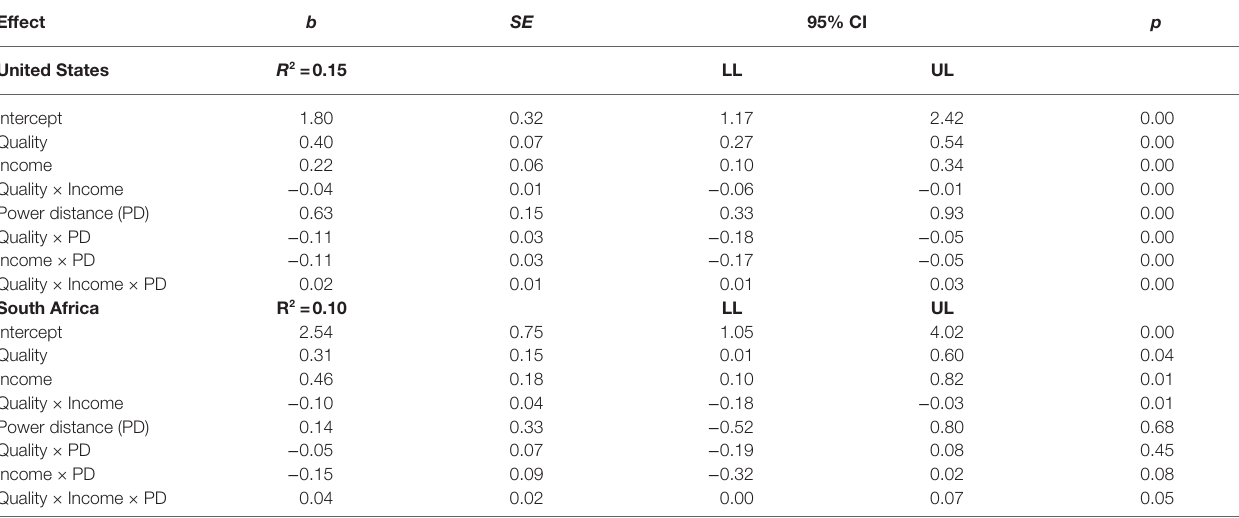
TABLE 3 | Moderation analyses for quality of instruction, power distance, and income on students’ well-being. Effect b SE 95% CI